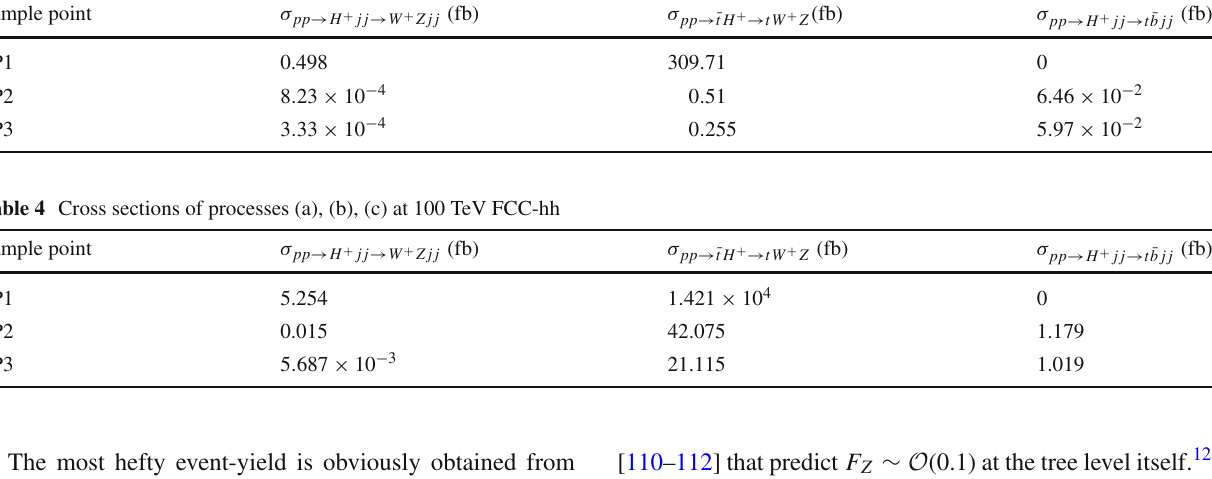
Table 3 Cross sections of processes (a), (b), (c) at 14 TeV LHC Sample point